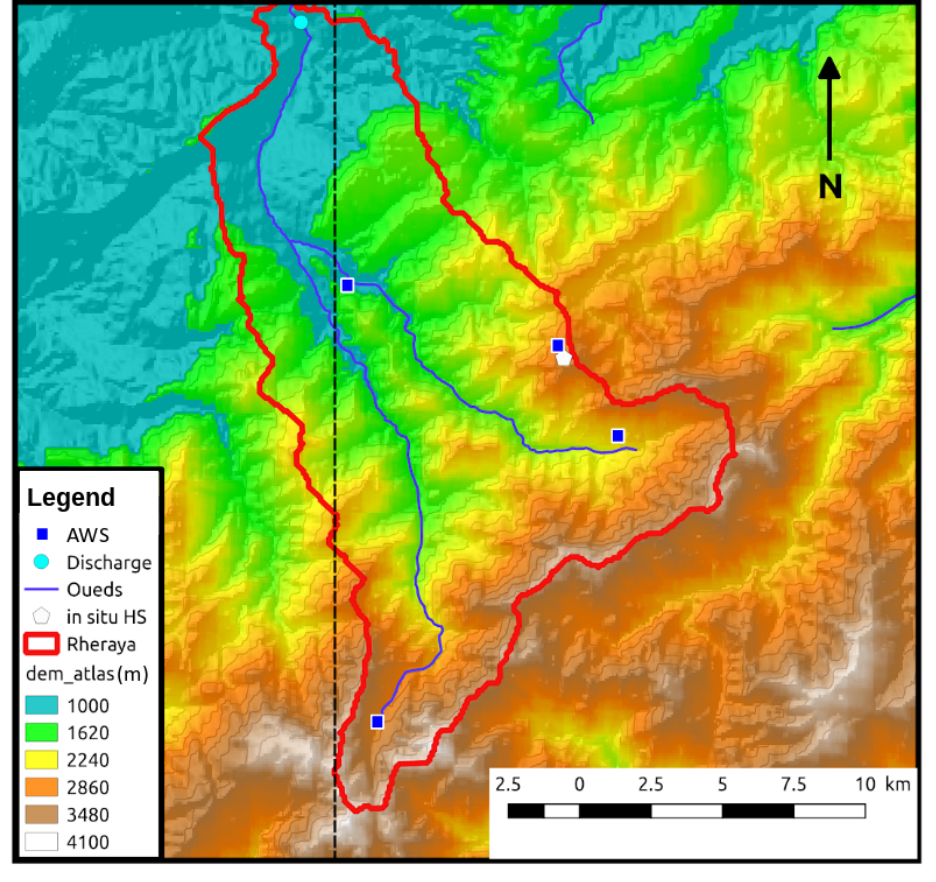
Figure 1. Elevations of the Rheraya catchment, and the location of discharge measurement (sky blue), in situ snow height (HS) and automatic weather stations (AWS). The dashed points refers to the intersection between Sentinel-2 images borders and the